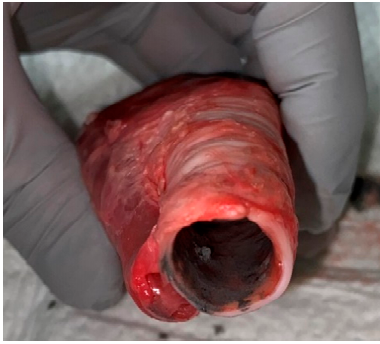
Figure 2. Trachea sample with soot applied prior to spectral collection.